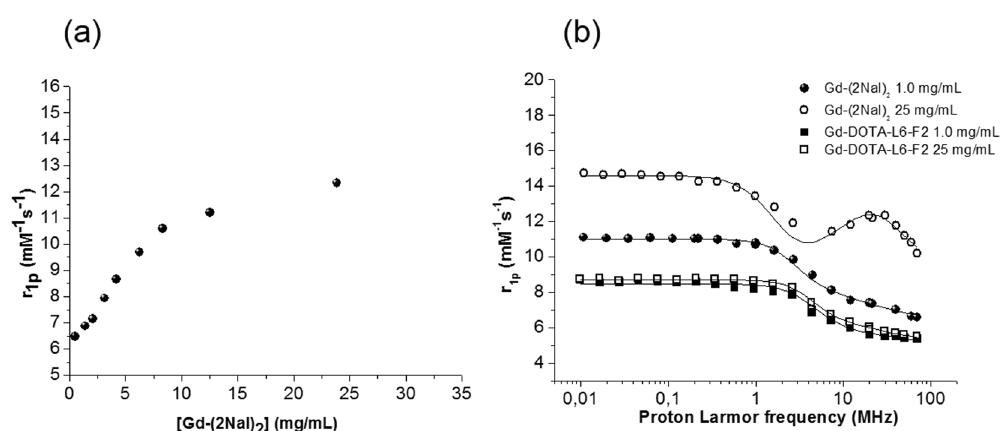
Figure 8. ( a ) Longitudinal proton relaxivity of Gd-DOTA-L 6 -(2Nal) 2 measured at 21.5 MHz (0.5 T) and 298 K as a function of the concentration of the Gd-complex. ( b ) NMRD profiles of Gd-DOTA-L 6 -(2Nal) 2 (1.0 mg/ mL ( ● ) and 25.0 mg/mL ( ○ )) compared to those of Gd-DOTA-L 6 -F2 (1.0 mg/mL ( ■ ) and 25.0 mg/mL ( □ )). Experimental data points were measured on aqueous solutions of the Gd-complexes at 298 K. The data refer to 1 mM concentration of the paramagnetic